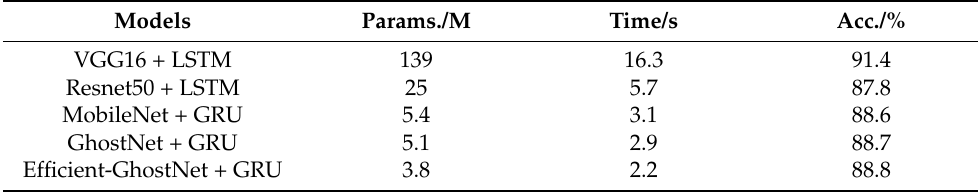
Table 2. Performance comparison of each model with the homemade dataset. Models